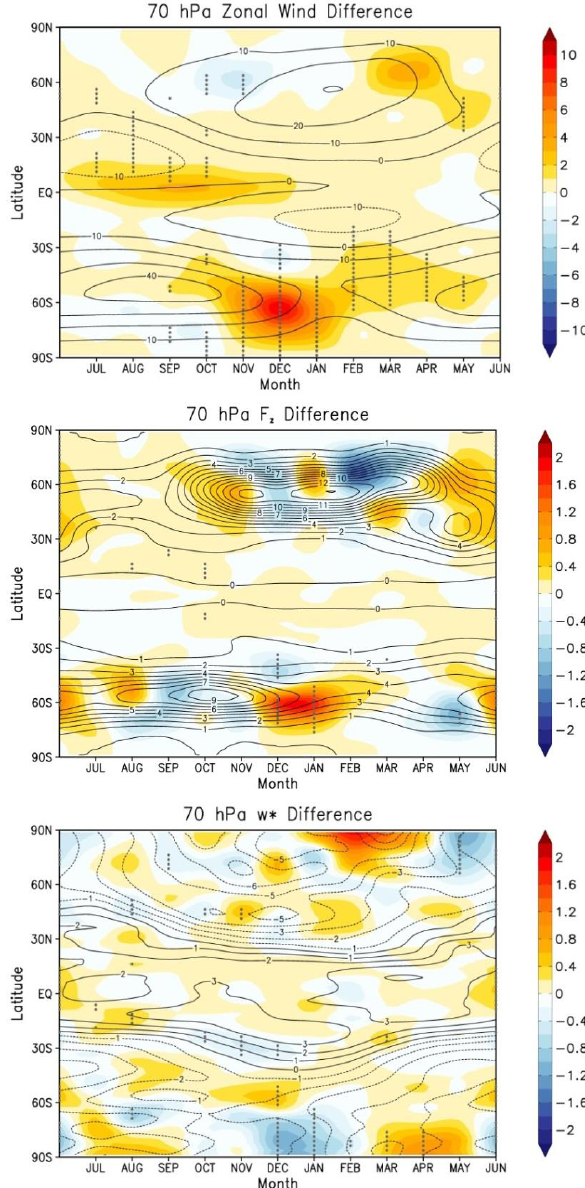
Figure 9: Zonal mean, monthly mean, zonal wind (top); vertical component of the EP flux Figure 9. Zonal mean, monthly mean, zonal wind (top); vertical component of the EP flux vector, F z (middle); and residual ver- vector, F , (middle); and residual vertical velocity, 𝑤̅ ∗ , (bottom) REF2000 climatology z tical velocity, w ∗ , (bottom) REF2000 climatology (contours) and difference between REF2000 and NHC (shaded), at 70hPa. Con- (contours) and difference between REF2000 and NHC (shaded), at 70 hPa. Contour intervals tour intervals for the REF2000 climatology are 10ms − 1 (top), for the REF2000 climatology are 10 m s -1 (top), 1x10 4 m 2 s -2 (middle) and 1 mm s -1 (bottom). 1 × 10 4 m 2 s − 2 (middle) and 1mms − 1 (bottom). Stippling denotes significance at the 95% confidence Stippling denotes significance at the 95% confidence level.